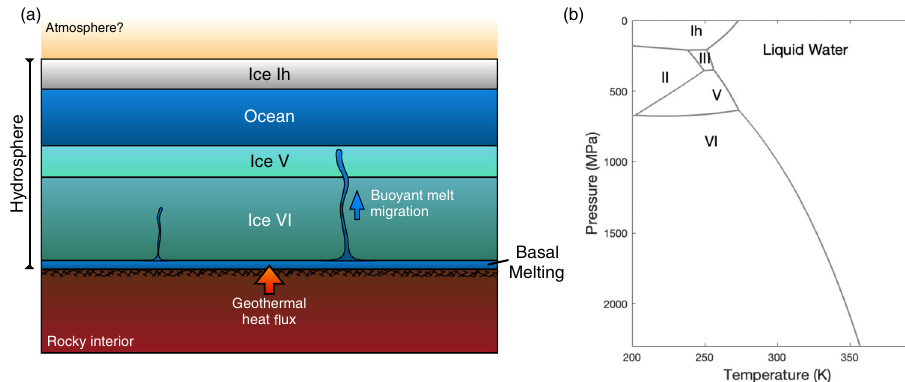
Fig. 2 | Schematicofa basalmelting modelfor icy exo-Earths.a Due to the high surface gravity of super-Earths, ice sheets may undergo numerous phase trans- formations. Liquid water may form within the ice layers and at the base via basal melting with suf fi cient geothermal heat. If high-pressure ices are present, melt- waterwillbebuoyantandmigrateupward,feedingthemainocean.Theredarrows